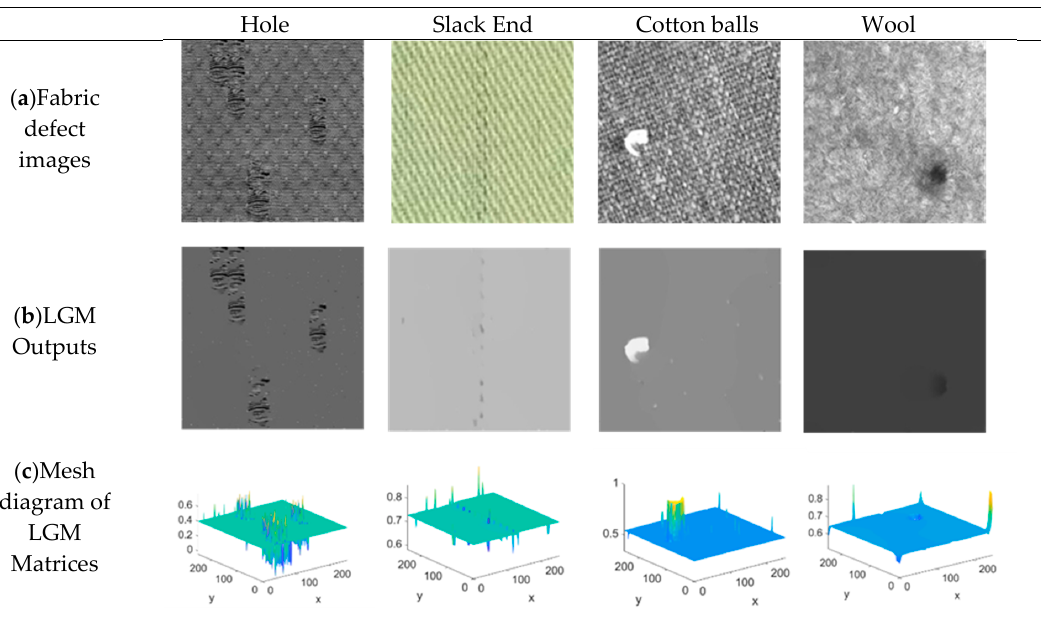
Figure 6. Results of fabric defect based on LGM.